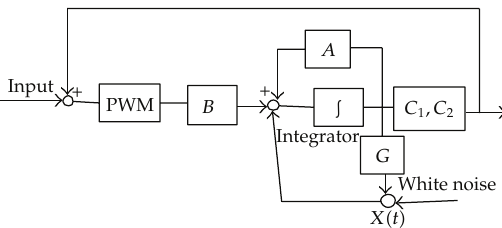
Figure 1: Block diagram of stochastic PWM feedback systems with time-varying